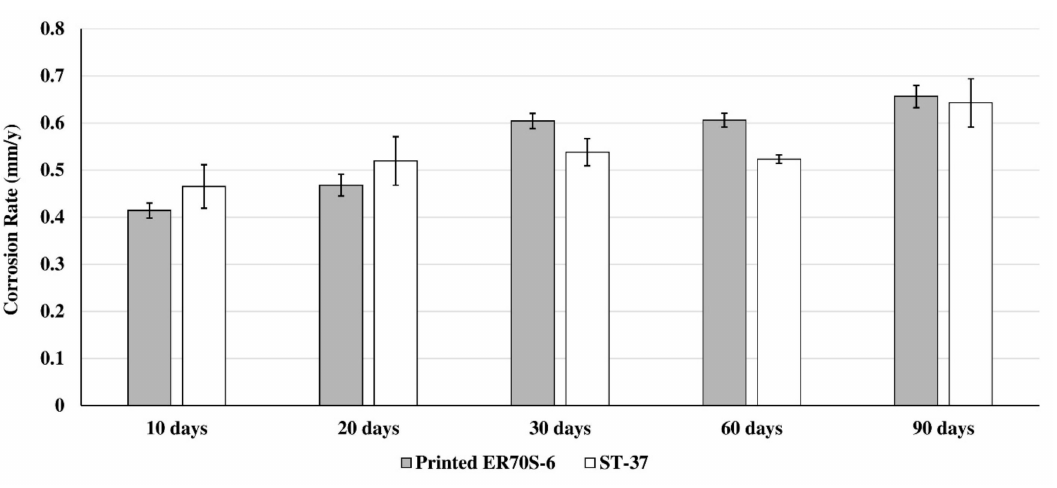
Figure 7. Corrosion rates of printed ER70S-6 alloy and reference ST-37 alloy following immersion testing for up to 90 days in 3.5% NaCl solution.